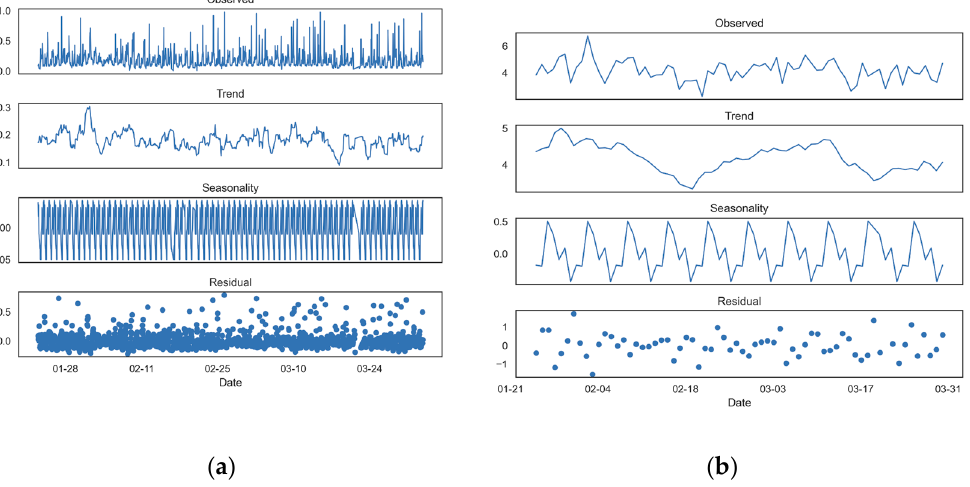
Figure 5. ( a ) Time series decomposition hourly basis. ( b ) Time series decomposition daily basis.